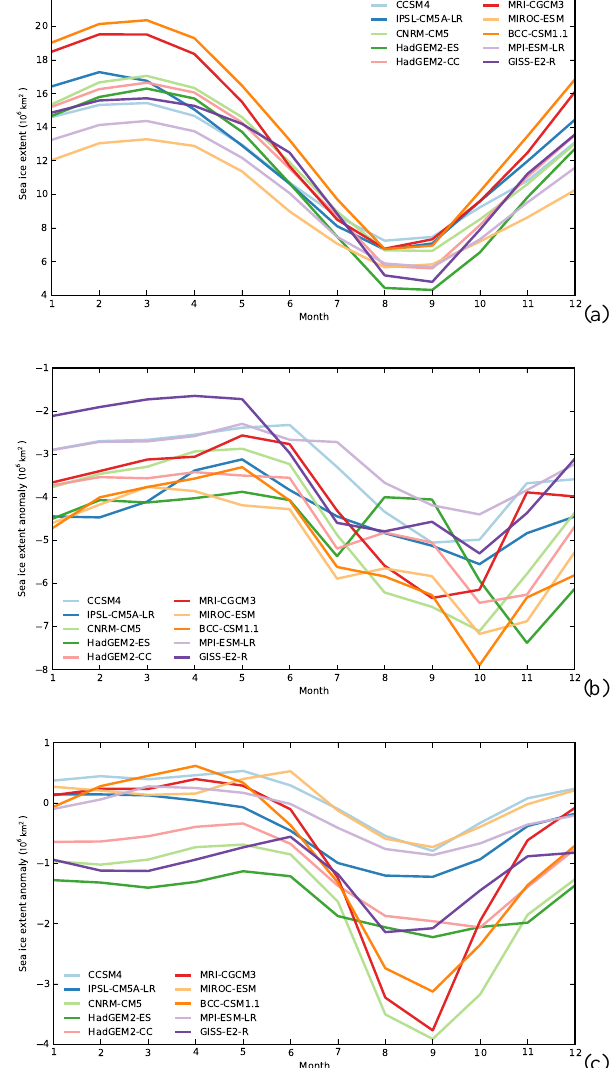
Fig. 7. Sea-ice extent in CMIP5 models in 10 6 km 2 . (a) 30-yr mean seasonal cycle for the period 1870–1900, (b) the anomaly in sea ice extent for the period 2036–2065 in RCP 8.5, and (c) the anomaly at the